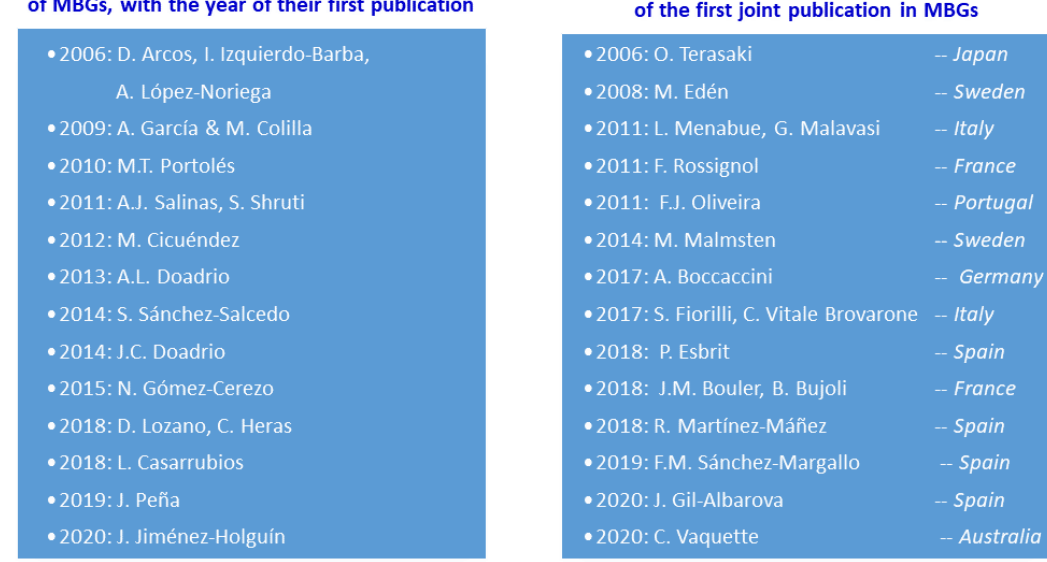
Figure 4. Members of the Vallet-Regí group and external collaborations in the field of MBGs.